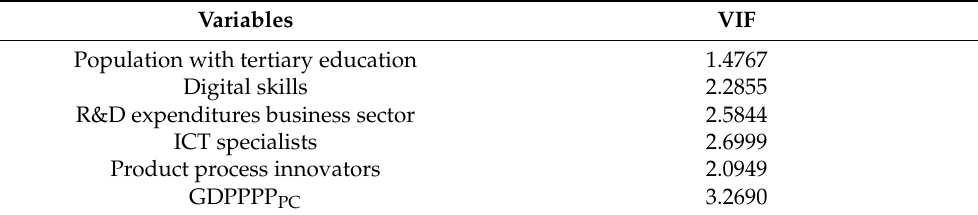
Table 10. Variance inflation factor.